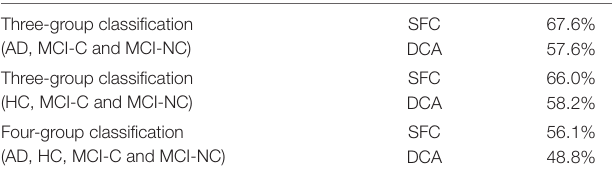
TABLE 2 | Accuracy of three- and four-group classification using the SFC and DCA feature selection algorithms. Three-group classification (AD, MCI-C and MCI-NC) Three-group classification (HC, MCI-C and MCI-NC) Four-group classification (AD, HC, MCI-C and MCI-NC)